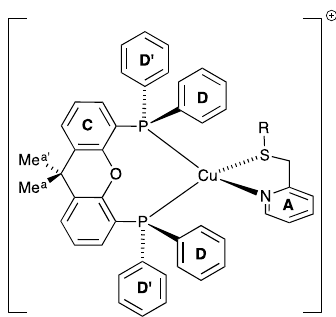
Figure 4. Aromatic region in the variable temperature 1 H NMR spectra of [Cu(POP)( i PrSPy)][PF 6 ] (500 MHz, acetone- d 6 ).